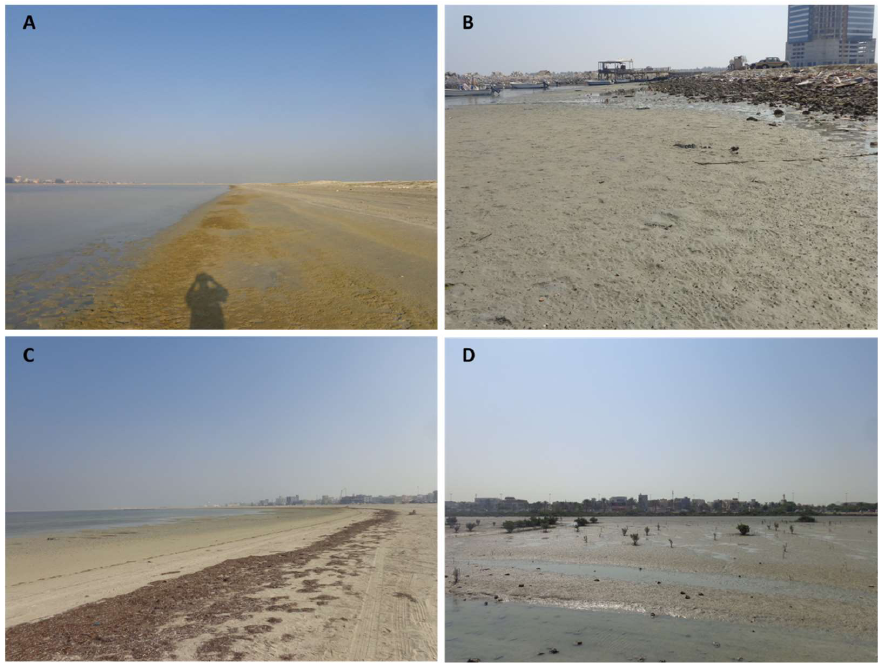
Figure 2. Images of the sampling areas: Nurana ( A ), Karbabad ( B ), Sayah ( C ) and Arad ( D ).